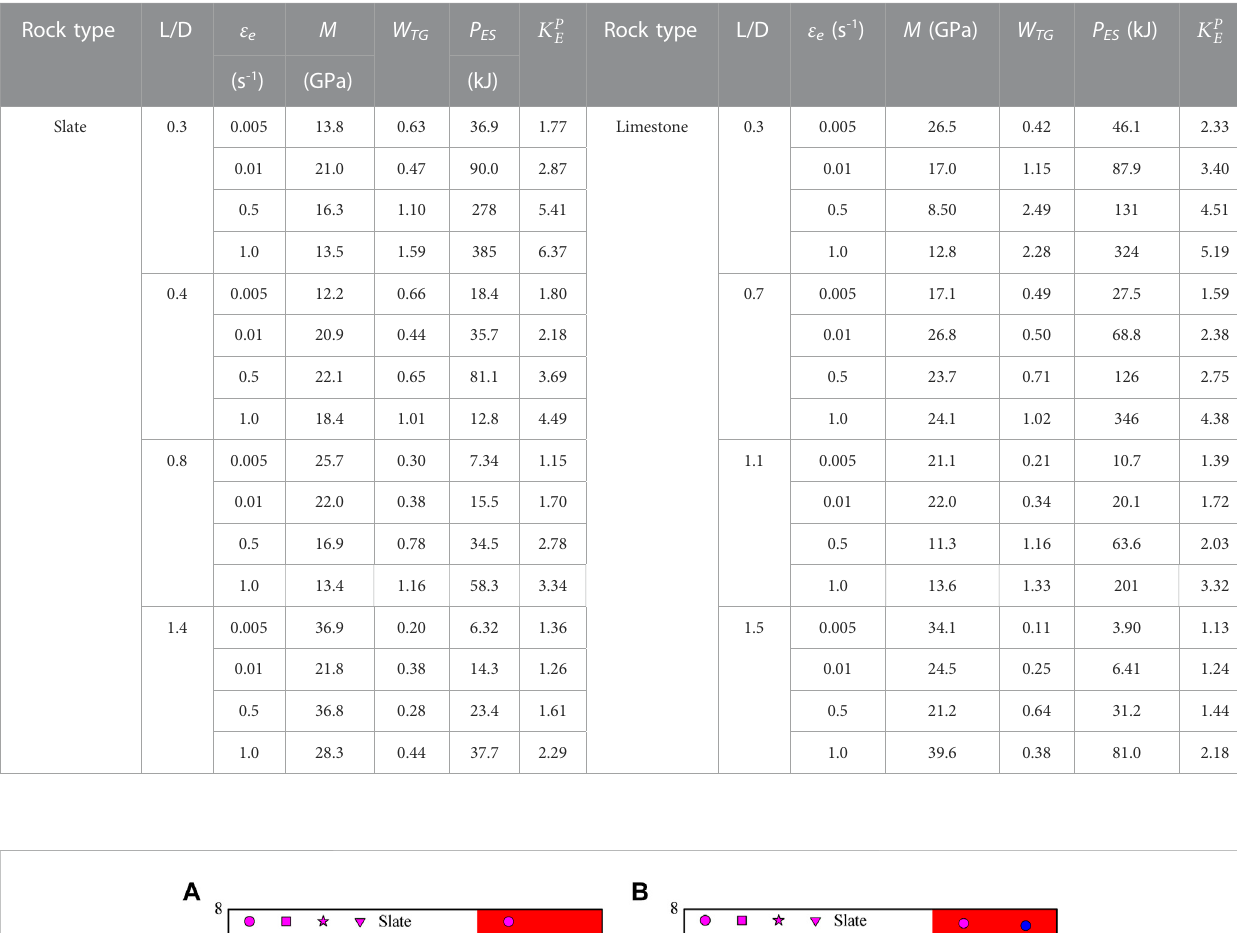
TABLE 5 Summary of rock burst proneness based on three indices from Liu S M et al. (2020), Ma ł kowski and Niedbalski (2020), and Bukowska (2005). Rock type